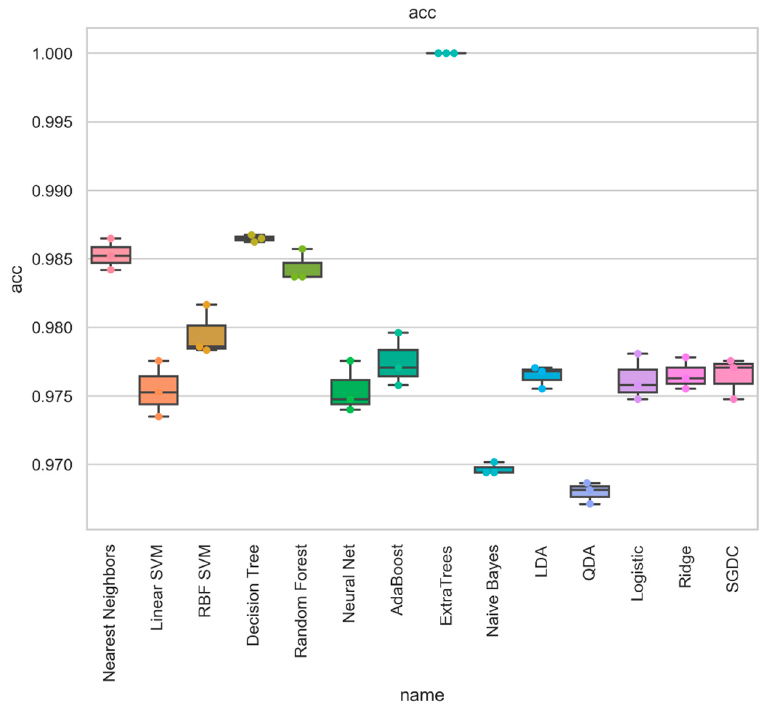
Figure 5. Comparison of performance of ensemble model by final-stage classifier: accuracy.